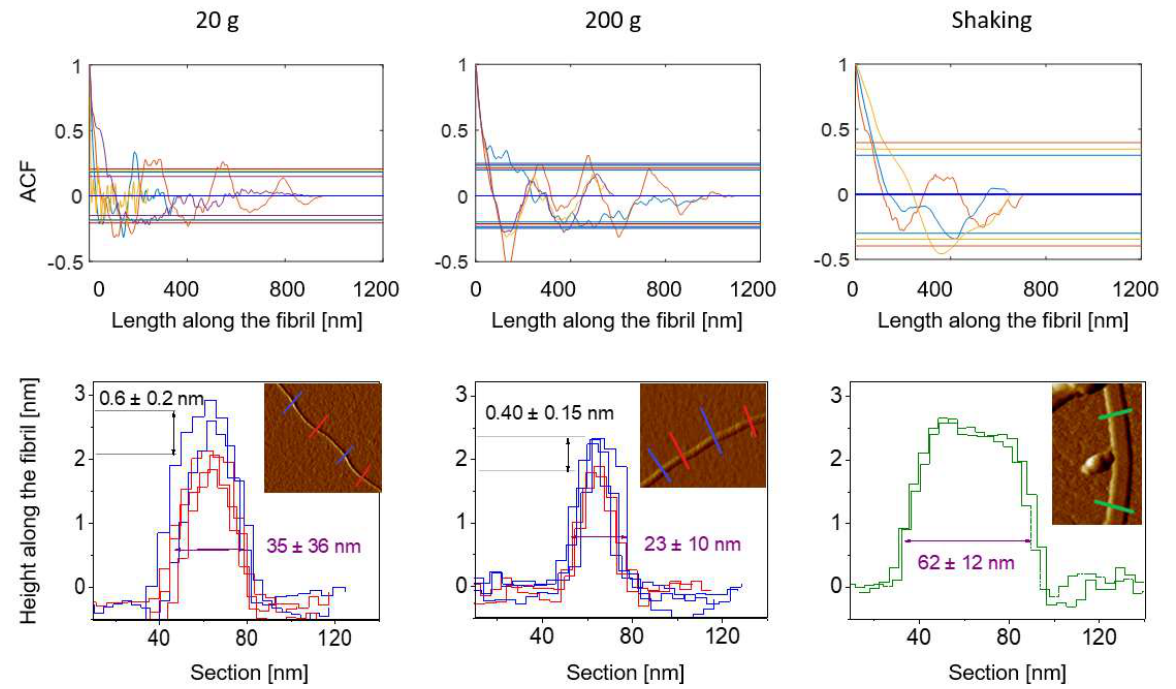
Figure 4. Morphological features of fibrils formed at different agitation modes for 20 mg/mL. Upper row—autocorrelation plots of fibril height profile. The color of the line corresponds to the arrows on the AFM image in Figure 2; horizontal lines represent 90% confidence thresholds; bottom row—cross-section height profile of fibrils. Red lines and blue lines correspond to the highest and lowest point of a periodic fibril, respectively. Green lines correspond to the cross-section of non-periodic fibrils. The graphs inserts are AFM images of the analyzed fibrils. The marked cross-sections have the same color as their plots on the corresponding graphs. Lysozyme samples were prepared at pH 1.5 with 15% EtOH and studied after 2 weeks of appropriate agitation at 42 °C.